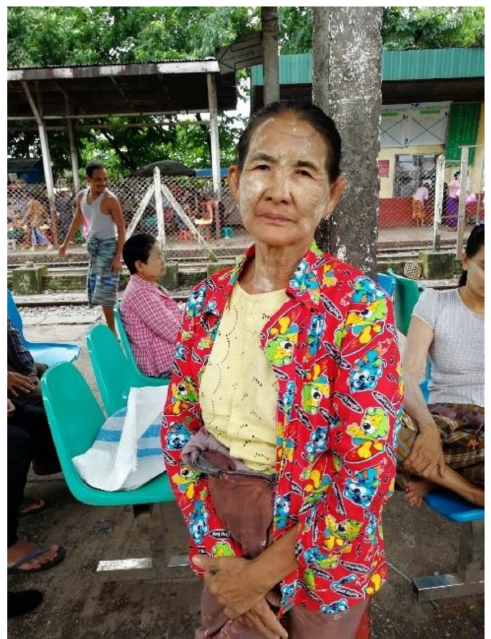
Figure 1. Burmese women wearing Thanaka paste. (Picture was taken by LT Gew during her visit to Yangon,